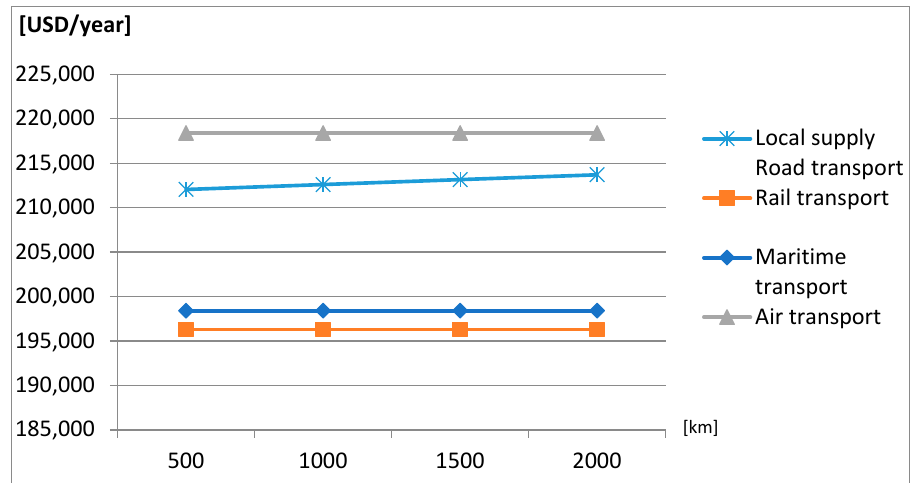
Figure 4. Results of simulations—impact on total costs (garment).